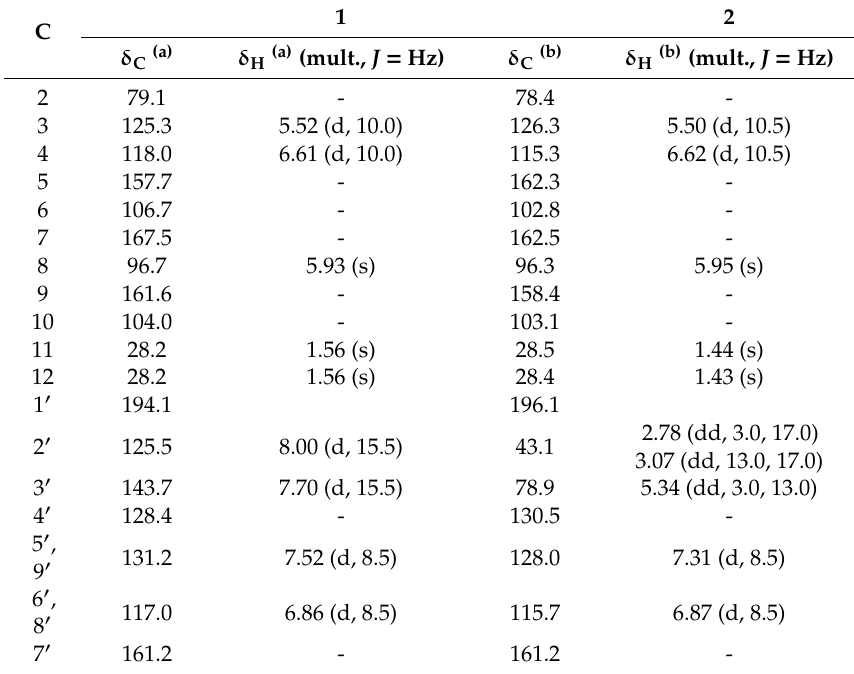
Table 1. 1 H and 13 C NMR spectroscopic data for compounds 1 and 2